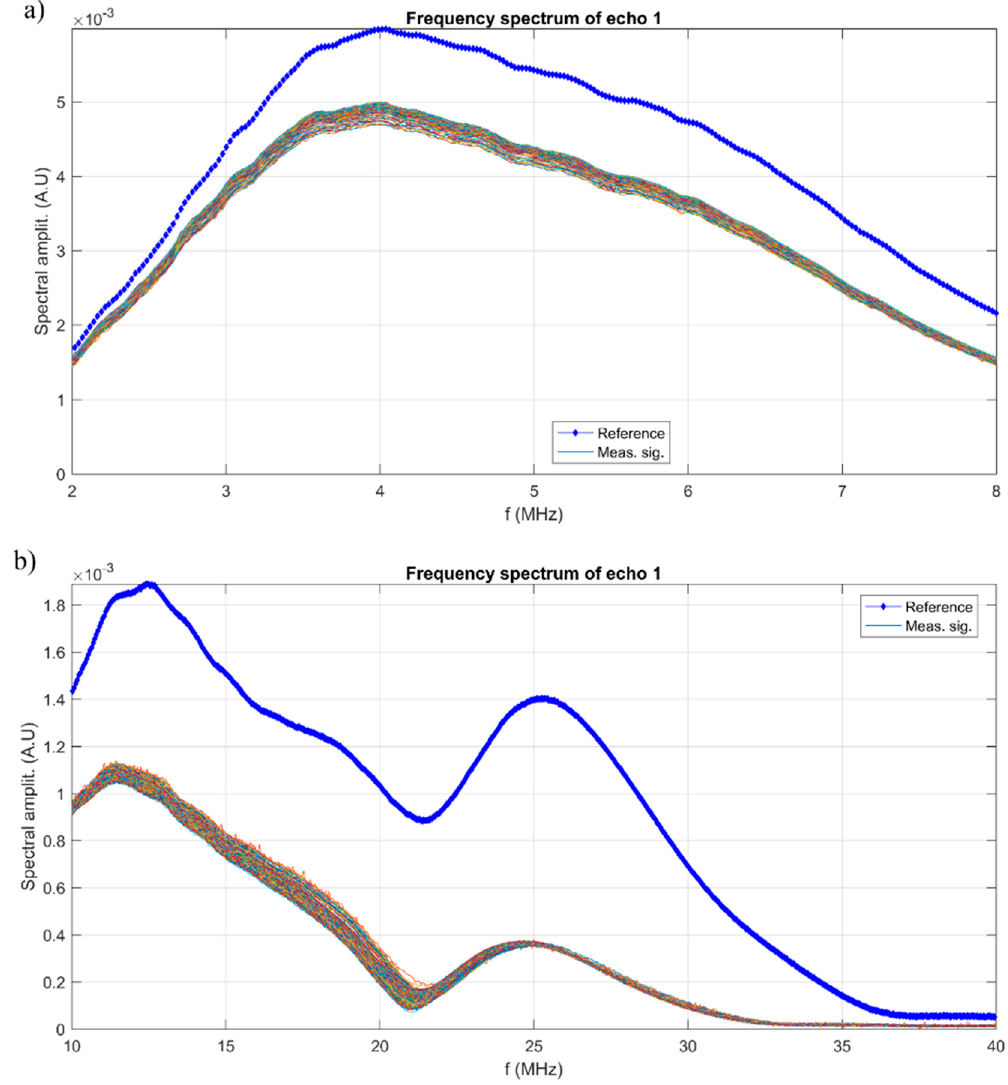
Figure 1. Frequency spectrum of the first transmitted echo at 5 MHz ( a ) and 25 MHz ( b ) central frequency for the AgZnHApCs suspension.